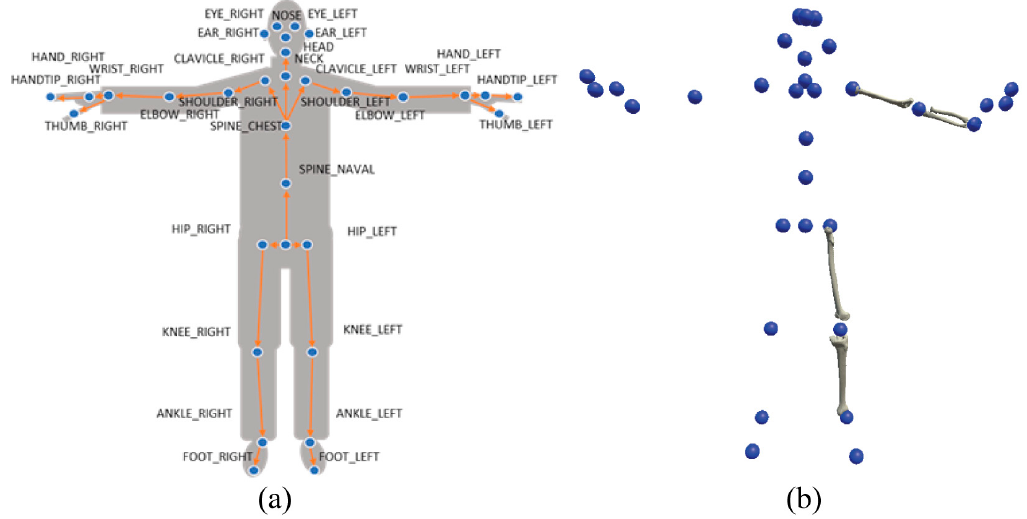
Figure 2. ( a ) Map of the joints tracked by the Azure Kinect; ( b ) Map of the 3D joint in Unity.